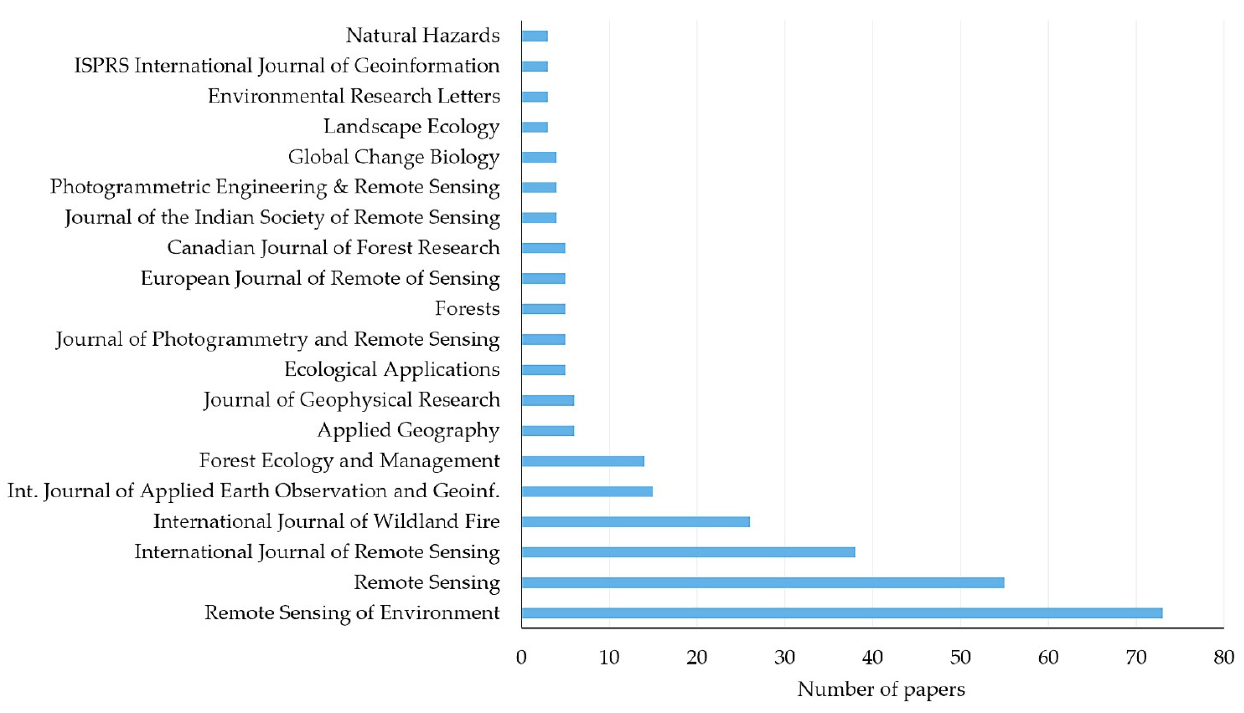
Figure 3. Top 20 out of 48 peer reviewed journals where the selected papers were published.